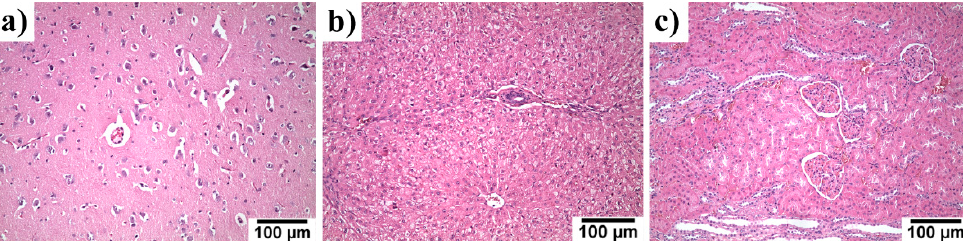
Figure 10. Histological examination of ( a ) brain, ( b ) liver, and ( c ) kidneys of rabbits 120 days after implantation with experimental screws. After 120 days there was no visible morphological/histopathological evidence of any toxic effect in the examined organs from the absorbable metals used. All specimens were processed in the routine way, i.e., paraffin-embedded, 5- µ m-thick sections stained with haematoxylin & eosin.